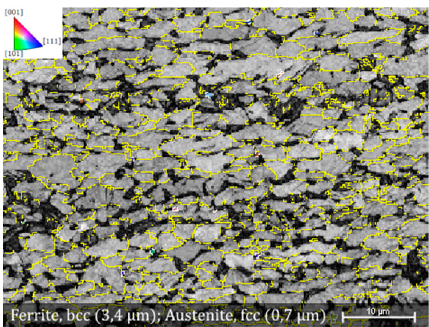
Figure 8. EBSD PQM phase map of Steel C IBT 450 tensile test sample where austenite (fcc) is presented in IPF X colouring with ferrite (bcc) and austenite (fcc) grain sizes overlaid.